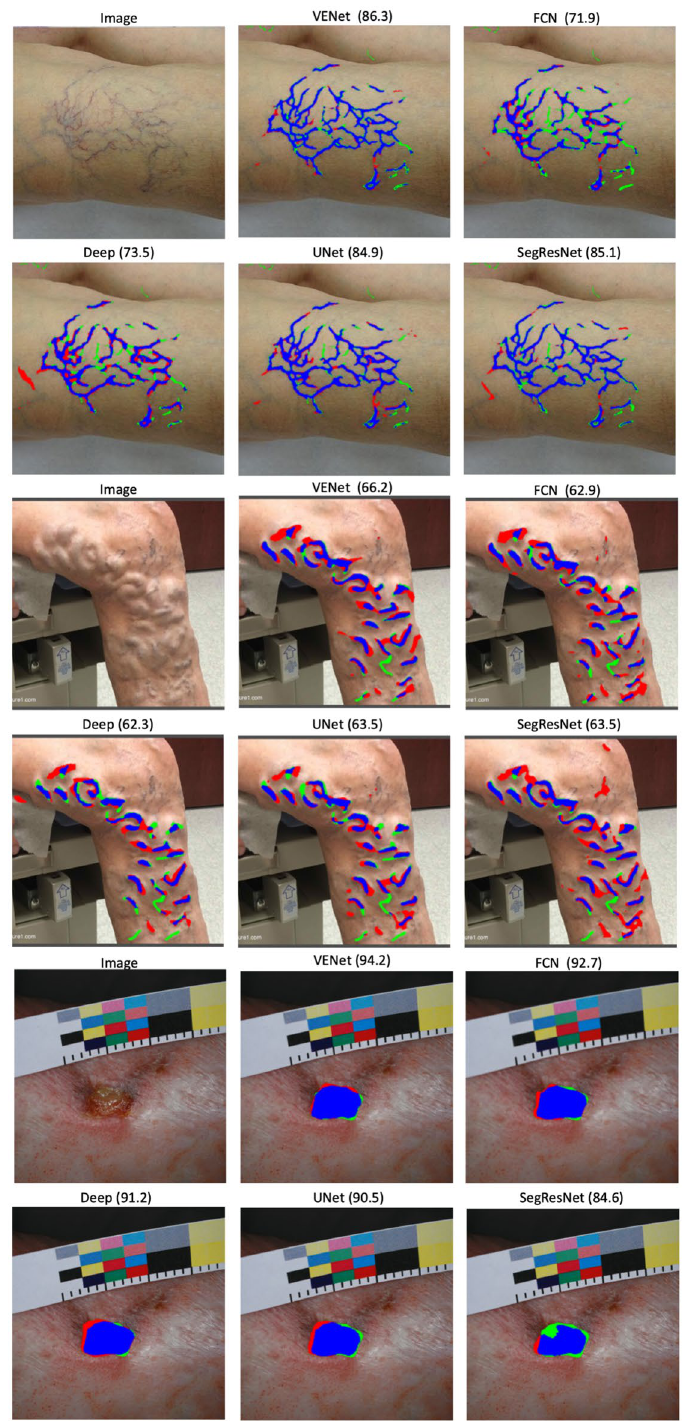
Figure 6. Segmentation examples of the proposed VENet and other conventional DCNN for the segmentation of CVD lesions, namely telangiectasias and reticular veins, varicose veins, and venous ulcers. The DICE metric is also provided for each segmentation result. The blue, red, and green colors represent the true positives, false positives, and false negatives,